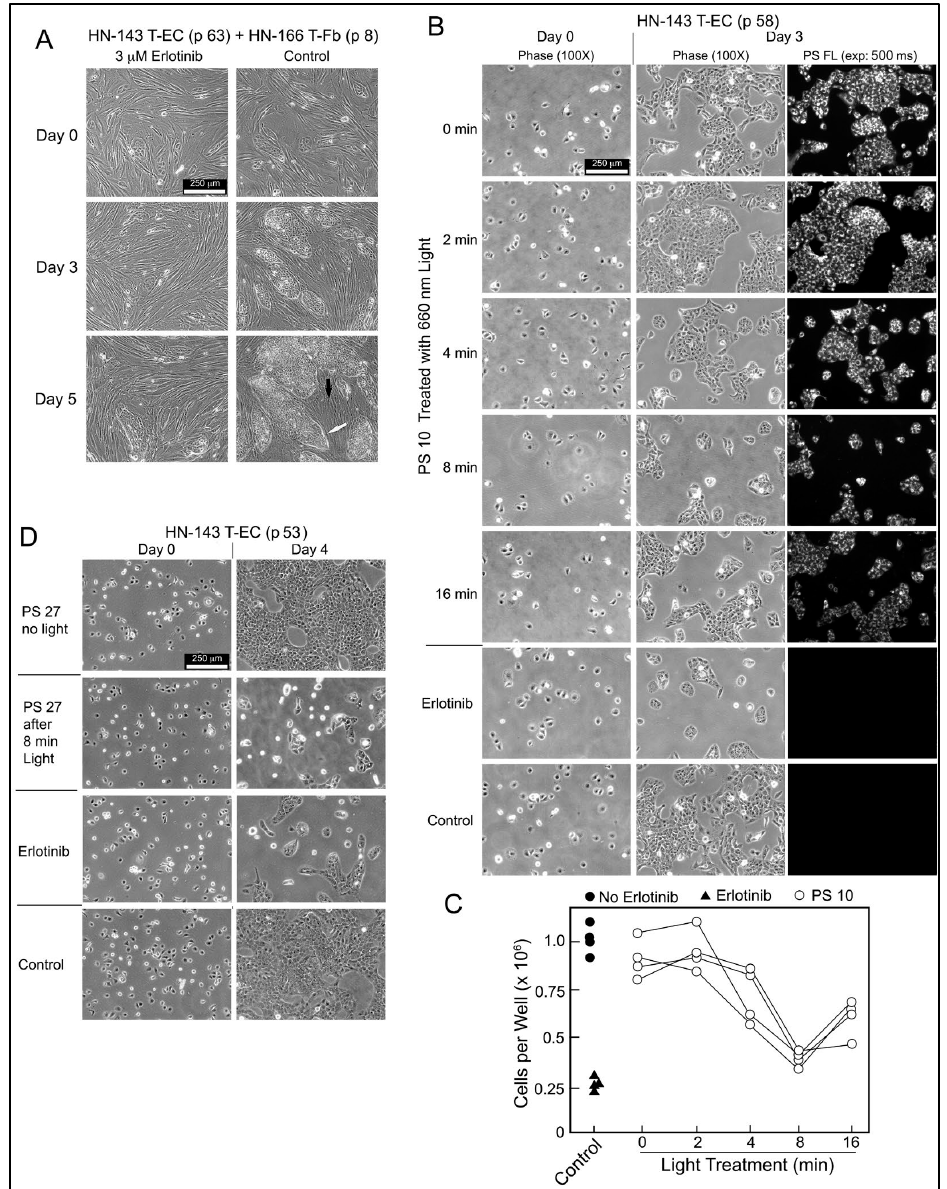
Figure 7. Inhibition of tumor cell growth by erlotinib and light-treated erlotinib-conjugates. ( A ), Three-day old co-culture of HN-143 T-EC (p 63) and HN-166 T-Fb (p 8) were incubated for 5 days in RPMI containing 10% FBS and with or without 3 μM erlotinib. Growth of the tumor cell clusters was monitored by microscopy. Tumor cell cluster is indicated by white arrow and interspersed stromal cell layer by black arrow. ( B ), HN-143 T-EC (p 58) were plated at 1/20 dilution (1 × 10 5 cells per well in 6-well plate) in RPMI containing 10% FBS and 3 μM aliquots of a PS 10 preparation illumi- nated between 0 and 16 min (0–5.3 J/cm 2 ). As reference served one well that included 3 μM erlotinib. Cells and PS fluorescence were imaged after 3-day incubation. ( C ), Four independent series of light treatments of PS 10 were tested for the effect on cell growth as shown in ( B ). The numbers of viable cells recovered after 3 d incubation were determined. ( D ), The erlotinib-like activity of 8 min light- treated PS 27 was tested on cultures of HN-143 T-EC (p 22) with incubation carried out for 4 d. The same cell assay also highlighted the accuracy of testing erlotinib conjugate prod- ucts by the response to light-treated PS 27 (Figure 7D). PS 27 has not been considered for further studies because it does not diffuse into cells, is poorly taken up by HN EC, and is